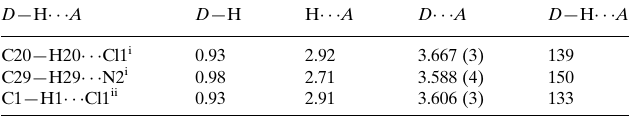
Hydrogen-bond geometry (A ˚ , (cid:3)